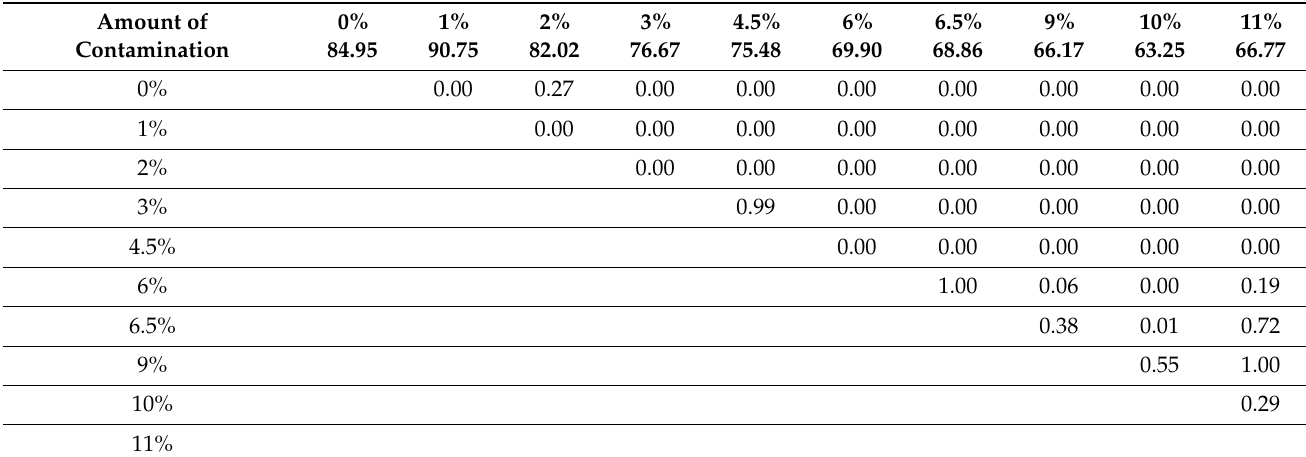
Table 5. Summary of the results of statistical analysis of the results of compressive strength tests depending on the degree of